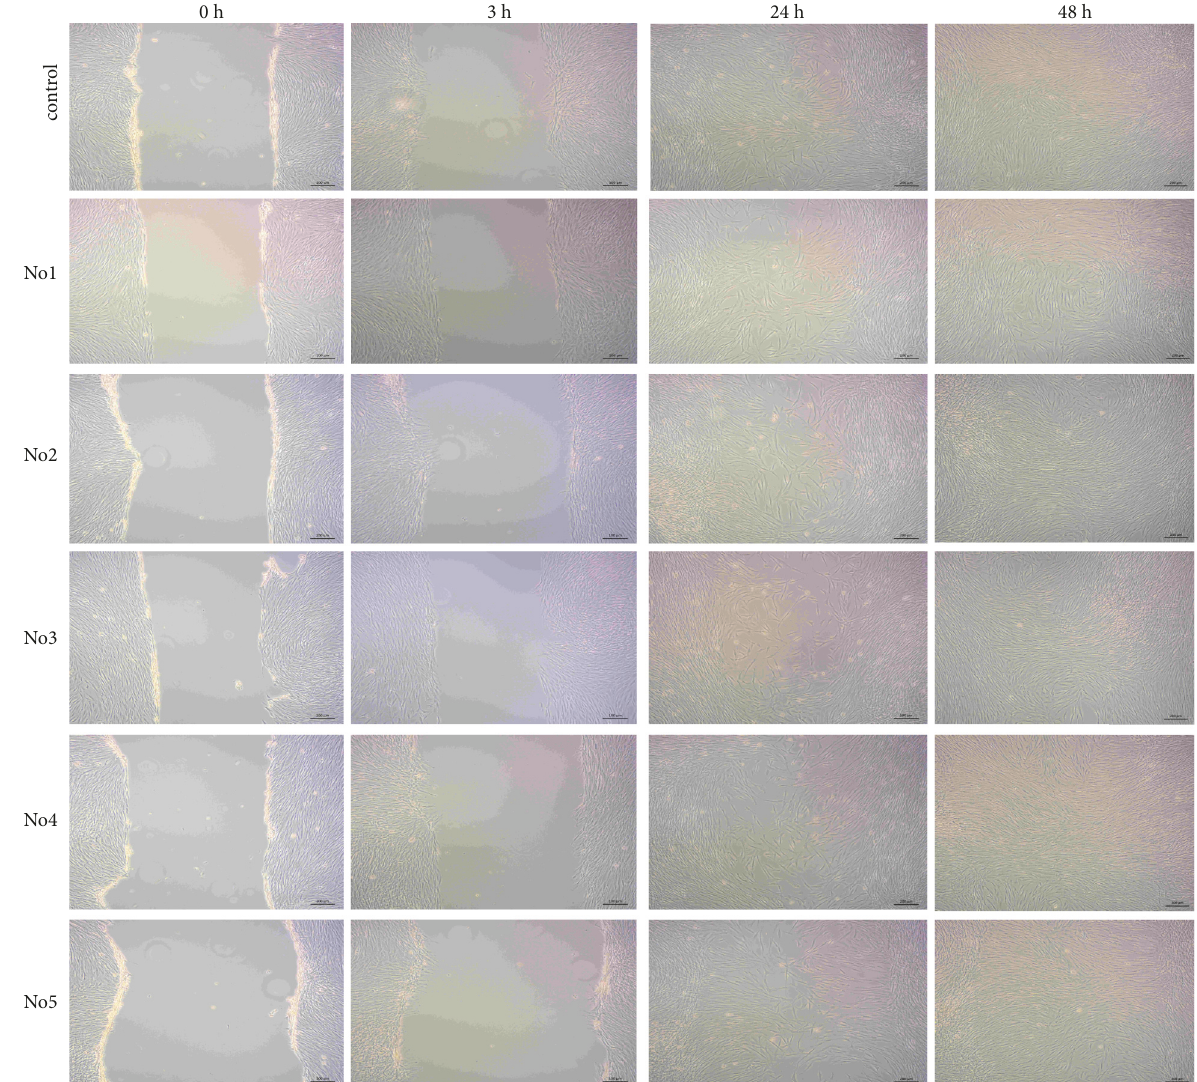
Figure 4: In vitro scratchassay with use of ADSCs in growth media with different deuterium content.Phase-contrastmicroscopy. Deuterium concentration: control: D/H 150 ppm; No. 1: D/H 500.000 ppm; No. 2: D/H 100.000 ppm; No. 3: D/H 10.000 ppm; No. 4: D/H 75 ppm; No. 5: D/H 15